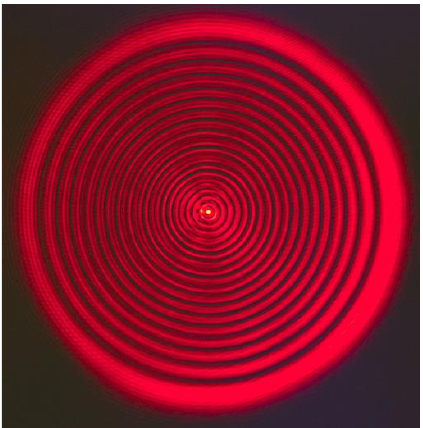
Fig. 2. Typical intensity distribution at transverse cross-section of SLB measured at 5 m from the SLB generator. Diameter of outer ring is 12.6